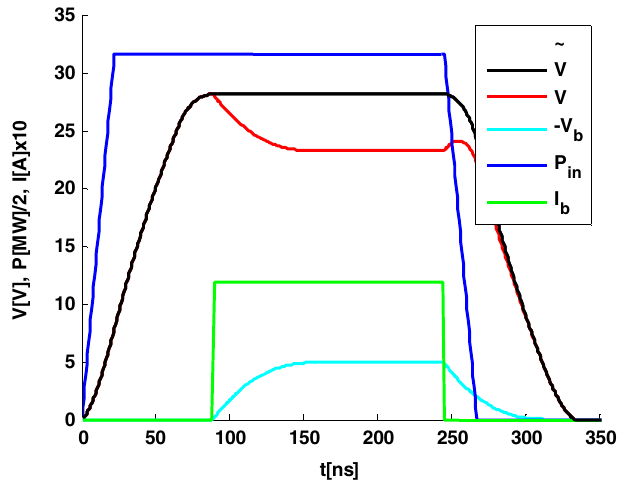
FIG. 5. The time dependence of the input rf power (blue) with a rise time of 22 ns, beam current (green), and the corresponding unloaded (black), loaded (red), and beam (light blue) voltages are shown.